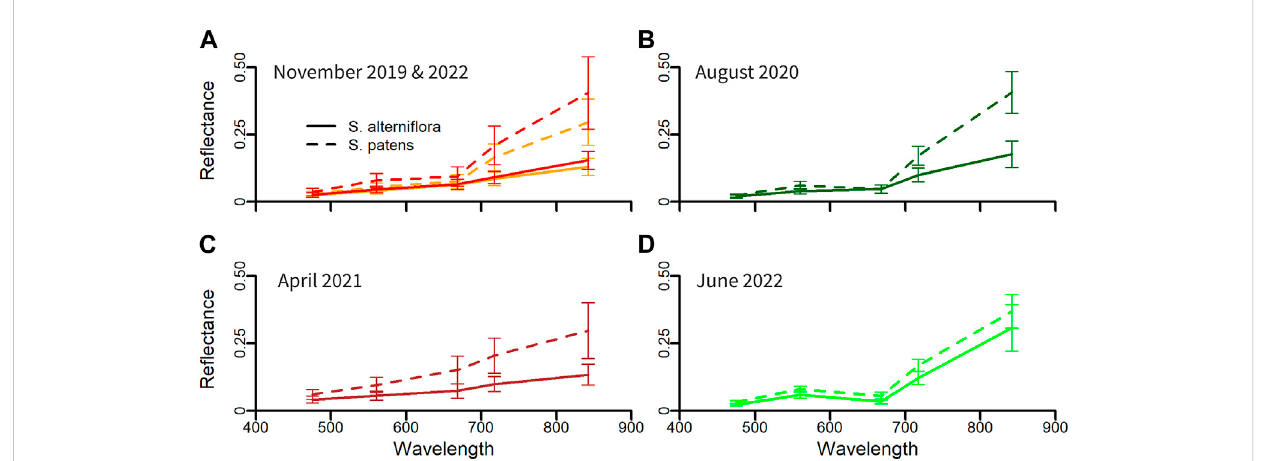
FIGURE 2 Multispectral re fl ectance spectra averaged from all Spartina alterni fl ora (solid line) and Spartina patens (dashed line) fi eld training points across (A) November2019(orange)andNovember2022(red), (B) August2020(darkgreen), (C) April2021 (brown), (D) June2022(lightgreen).Errorbarsrepresent standard deviation of re fl ectance at each band.